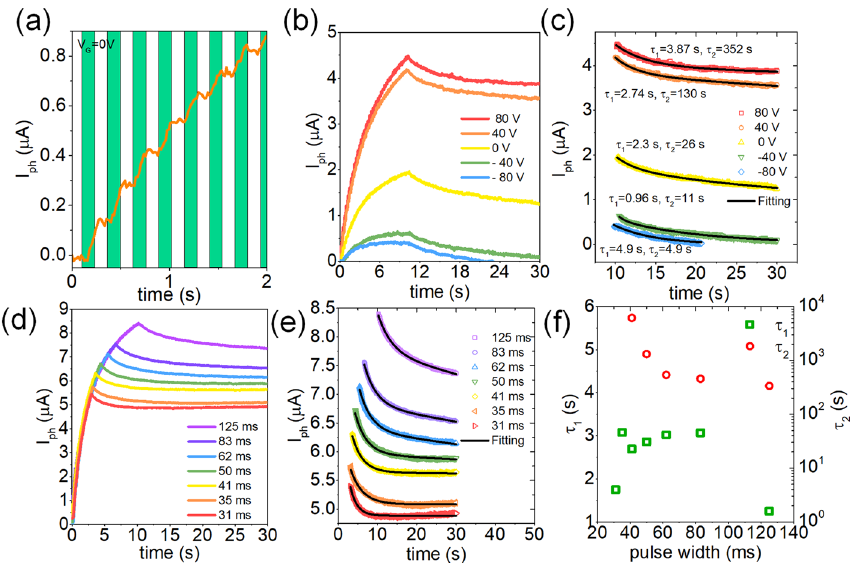
Figure 2. ( a ) Photocurrent measured across the top graphene layer as a function of time, when pulses of light (λ = 405 nm), of duration t ON = 125 ms, t OFF = 125 ms, are incident on the device. ( b ) Photocurrent measured across top graphene layer as a function of time, with varying back gate voltage. ( c ) Photocurrent retained after withdrawal of light as a function of time, fitted with a double exponential, indicating a fast decay with time constant τ 1 followed by a slow decay of current with a time constant of τ 2 . ( d ) Photocurrent as a function of time with varying light pulse width. V G = 80 V, V TGr = 0.1 V. ( e ) Retained photocurrent after light pulse withdrawal as a function of time from ( d ), fitted with a double exponential. ( f ) Photocurrent decay time constants τ 1 and τ 2 , extracted from ( e ), as a function of pulse